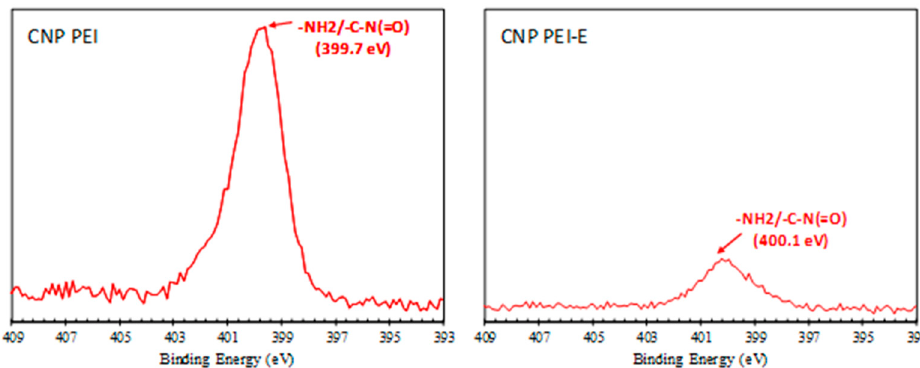
Figure 8. N 1s XPS spectra of CNP PEI and CNP PEI-E.